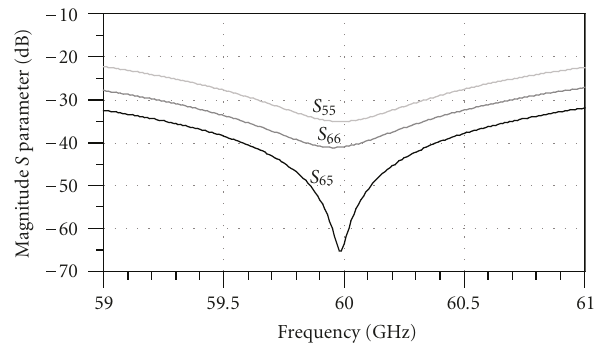
Figure 4: Simulation results of the return loss and isolation at RF inputs.